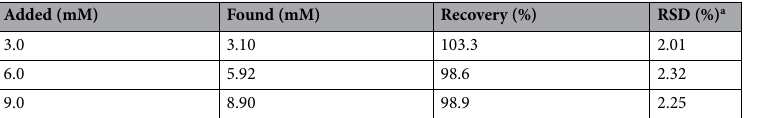
Table 2. Determination of glucose in human serum samples by PtNi alloy-graphene/GC electrode. a The Related standard deviation (RSD) is calculated according to n =